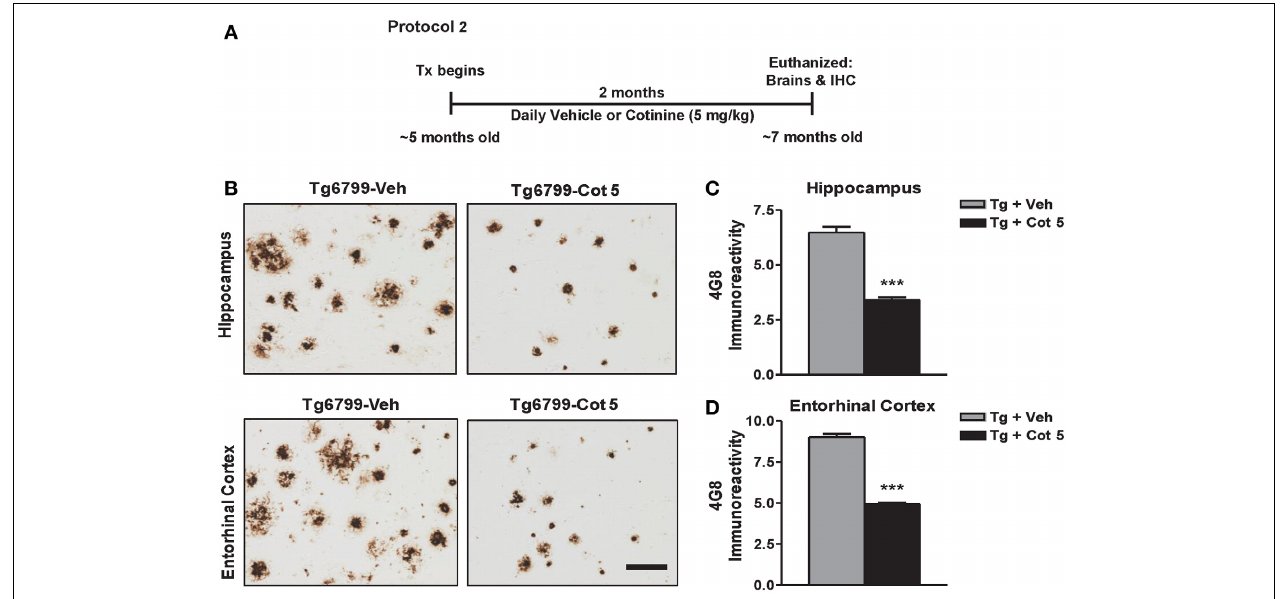
FIGURE 2 | Cotinine reduces A β plaques in the hippocampus and entorhinal cortex of Tg6799 mice. Transgenic (Tg) mice at 4.5–5 months of age ( n = 8 per group) were treated daily for 2 months with vehicle (Veh) or Cotinine (5mg/kg; Cot 5), euthanized and A β immunoreactivity (IR) in the hippocampus and entorhinal cortex was measured by immunohistochemistry (IHC; A ). Tg mice treated with cotinine (Tg + Cot 5) showed less A β plaques in the hippocampus and entorhinal cortex compared to vehicle-treated Tg mice